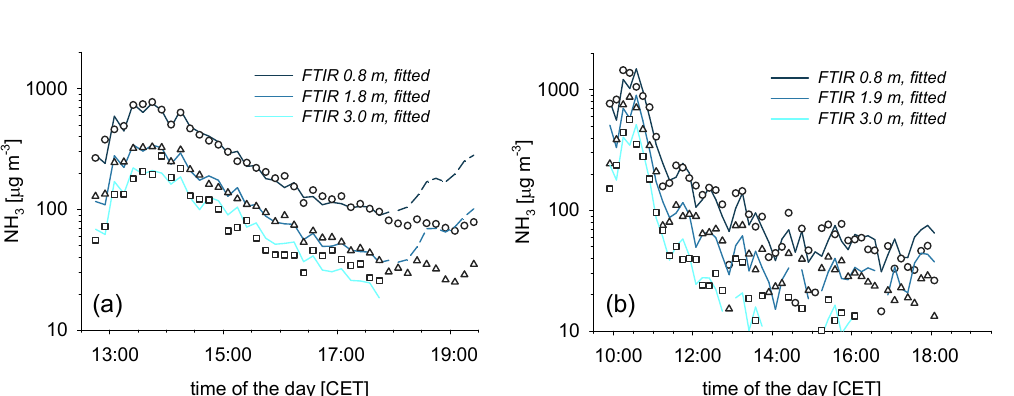
Fig. 6. NH 3 concentrations measured by FTIR systems and corresponding c FTIR , fit on (a) 4 August 2009 and (b) 6 August 2009; open symbols show the measured values at the various measurement heights: circles=0.8m, triangles=1.8 and 1.9m, squares=3.0ma.g.l.; dashed lines indicate periods when the parameterisation was regarded not to reflect representative surface emissions anymore, but the field was considered to emit